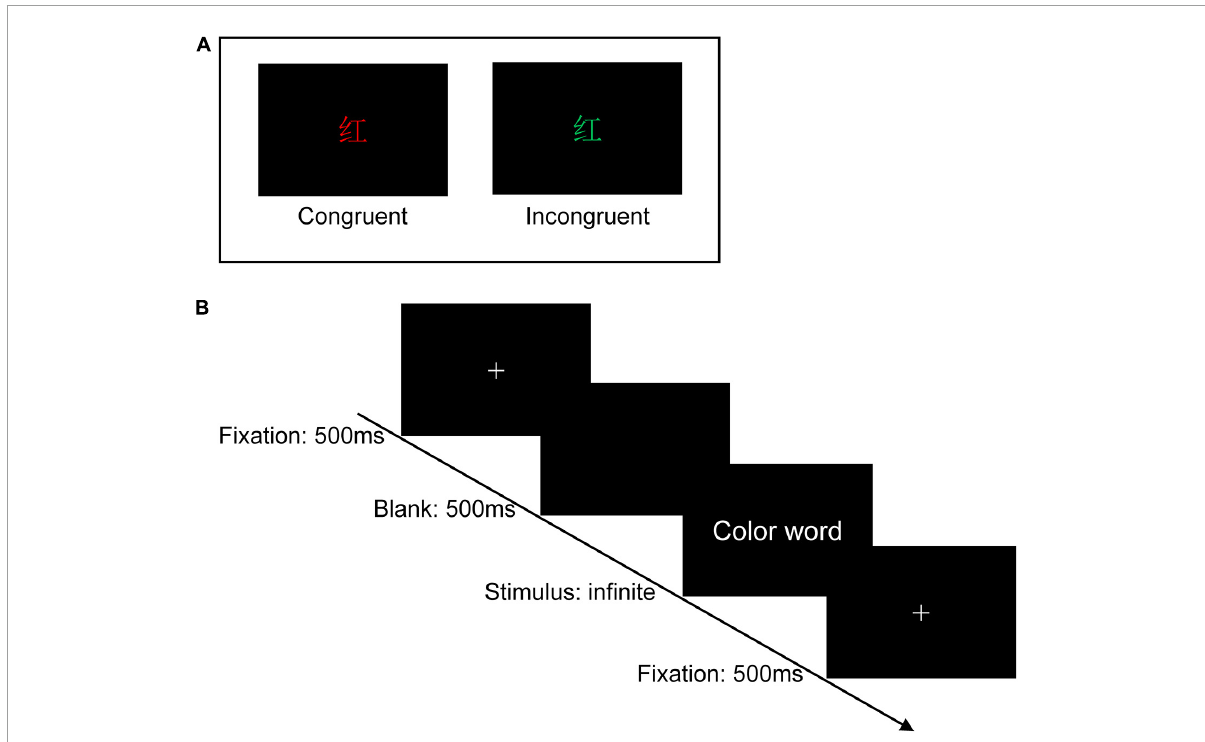
FIGURE2 Experimental design. (A) Two examples of the Stroop task (Chinese character “ ” means red). (B) Single-trial settings. During each trial, a white cross was first shown on the center of the black background for 500 ms, followed by a blank screen (500 ms), and then the color words appeared on the center of the black background, which was remained on the screen until participants pressed the specific